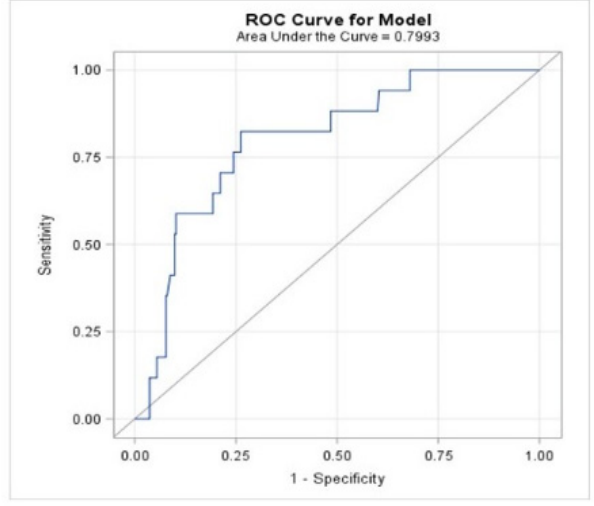
Figure 1. Receiver operating characteristic curve for D-dimer levels as a parameter for predicting pulmonary embolism in the COVID-19 cohort. The AUC for the model was 0.799.5% (0.699–0.899). The threshold for the D-dimer level was 2.59 µ g/dL, which showed a sensitivity of 82.4% (59.0–93.8%), specificity of 73.8% (68.3–78.7%), positive predictive value of 16.3% (10.0–25.5%) and negative predictive value of 98.5% (95.8–99.5%).